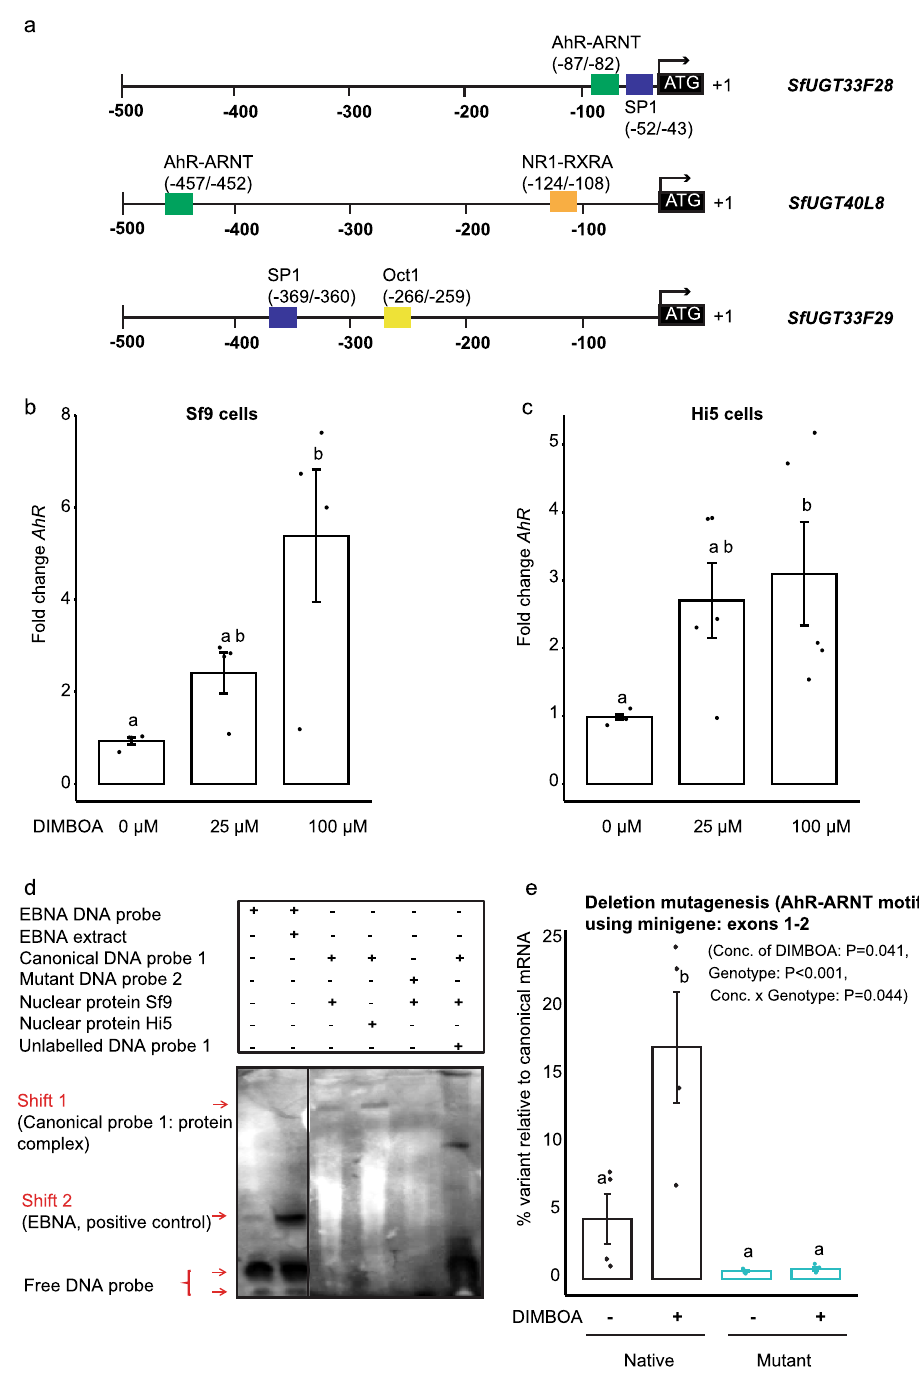
Figure 4. Aryl hydrocarbon receptor (AhR) regulates formation of SfUGT33F28 transcript variants. ( a ) Schematic depiction of 5 ′ promoter elements in SfUGTs ( AhR aryl hydrocarbon receptor, ARNT aryl hydrocarbon receptor nuclear translocator, SP1 specificity protein 1, NR1/RXRA nuclear receptor 1/retinoid X receptor A, Oct1 Octamer 1). ( b , c ) Quantitation of AhR transcript levels in DIMBOA-treated Sf9 and Hi5 insect cells by real time PCR (n = 4–5). ( d ) Electrophoretic mobility